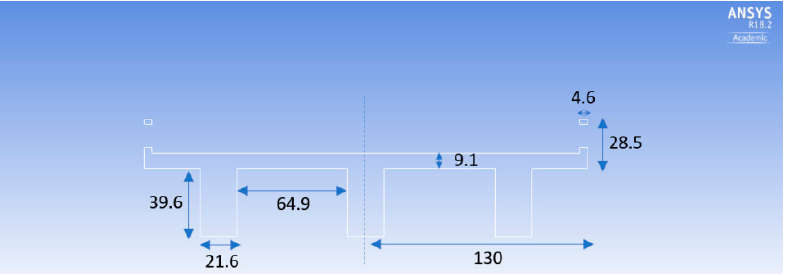
Figure 29. Dimensions of three girder deck in mm.